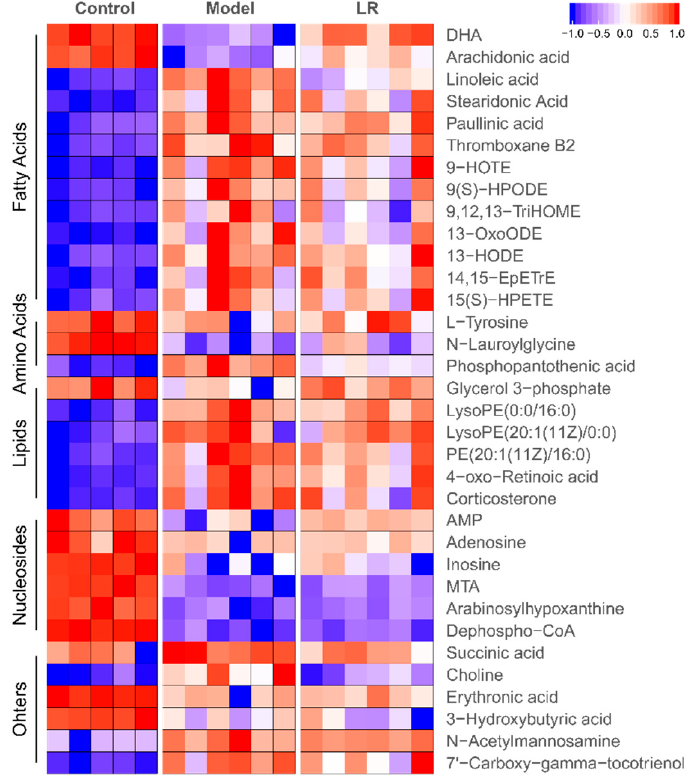
Figure 3. Heatmap of metabolites in the liver of mice from the control, model, and LR groups. Data (peak areas) were normalized between –1 and 1 (blue—the lowest level; red—the highest level). DHA: Docosahexaenoic acid; AMP: Adenosine monophosphate; MTA: 5’-Methylthioadenosine.